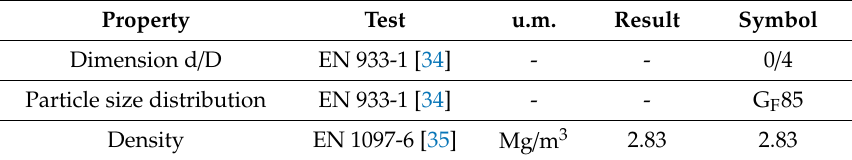
Table 5. Properties of dolomite aggregate 0 / 4 (L).